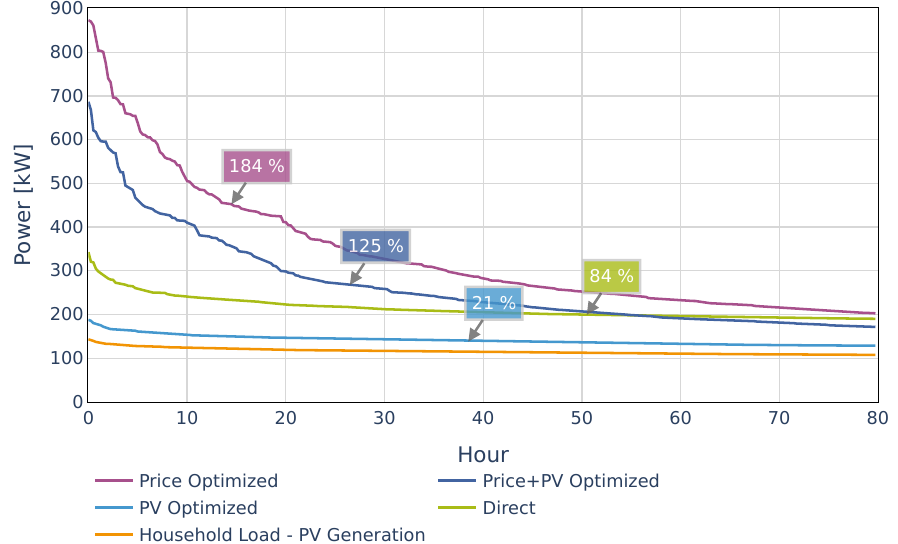
Figure 19. Largest 1% values of sorted grid load for each charging configuration and household load minus PV generation. Annotations show the increase of grid load compared to household load minus PV